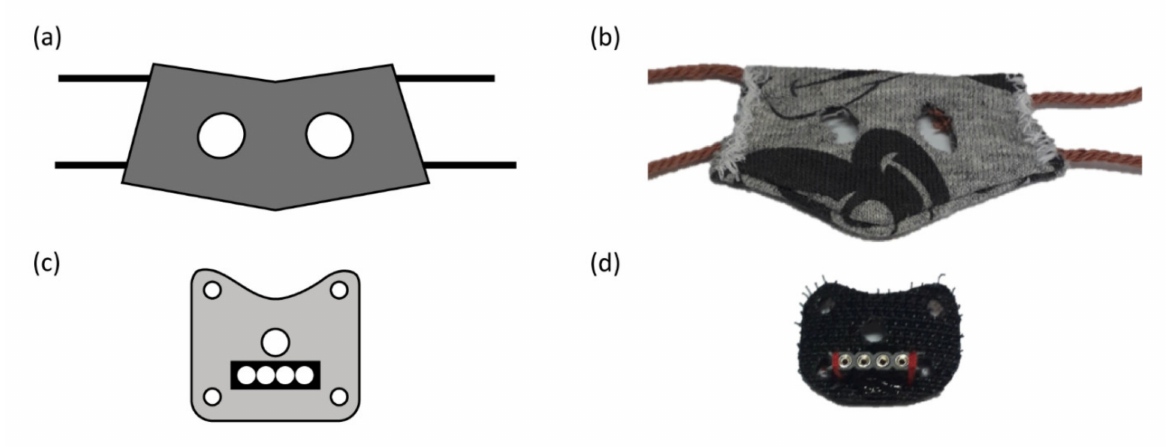
Figure 1. Schematic representation and picture of the in-house developed harness. ( a , b ) Corset piece with cut-outs for the front paws and two pairs of strings attached to the lateral side. ( c , d ) Rigid platform with central hole for the electrode leads and one hole at each corner for connection to the strings of the corset. Black rectangle represents connector strip (female side exposed) with four insertion places for each electrode